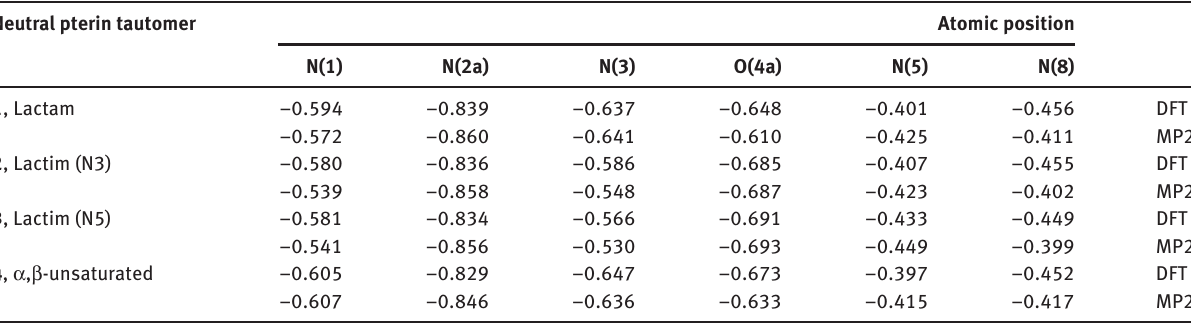
Table 2 Calculated natural charge of selected atoms of neutral 6-methylpterin tautomers (NPA density matrix calculated using B3LYP/6- 31+G** and